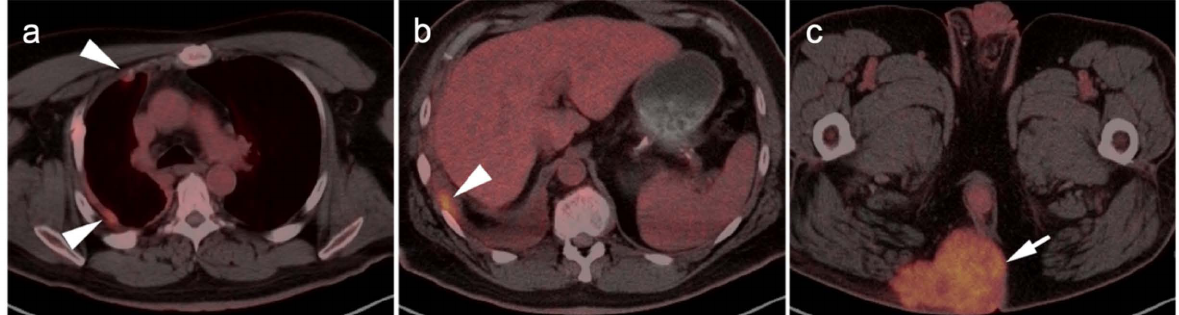
Figure 11. Metastatic Merkel cell carcinoma. ( a , b ) Axial FDG PET-CT images of the upper ( a ) and lower ( b ) chest show multiple metastatic hypermetabolic tumor deposits to the right pleura (white arrowheads). ( c ) Axial FDG PET-CT of the low pelvis shows a large primary tumor of the skin and subcutaneous tissue of the right buttock (white arrow).